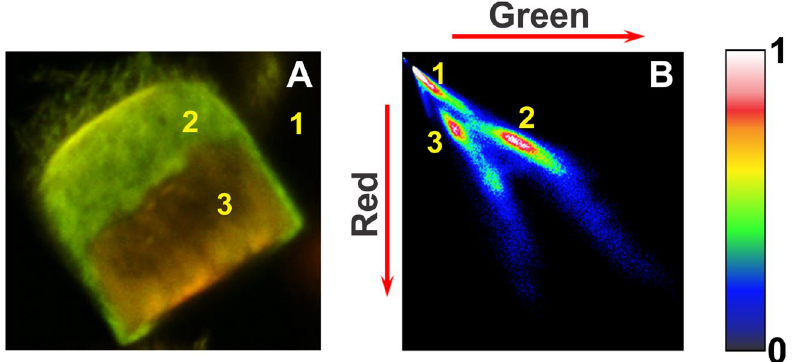
Figure 7. Distribution analysis for aS140C-MFM in SFAs. ( A ) CLSM image of an SFA that is analyzed. ( B ) Red intensity vs Green intensity contour map. Populations 1, 2, 3 correspond to the background, more polar external part of SFA, and more apolar internal part of SFA